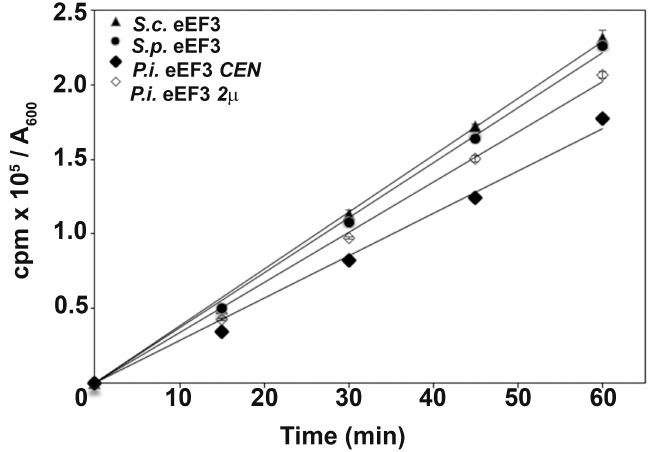
Fig 3. Strains expressing P . infestans eEF3 exhibit a reduction in protein synthesis. S . cerevisiae strains expressingeEF3 from the indicatedspecies( S . cerevisiae(S . c . ) , S . pombe (S . p . ) , and P . infestans(P . i . ) were grown to log phasein C-MET at 30˚C. [ 35 S] methionine was added and total protein synthesis was measuredby tricholoroacetic acid precipitation.Incorporation(counts per min) is expressedper A 600 unit. Each time point was performed in triplicate and error bars represent standarderror. A representative experiment is shown.